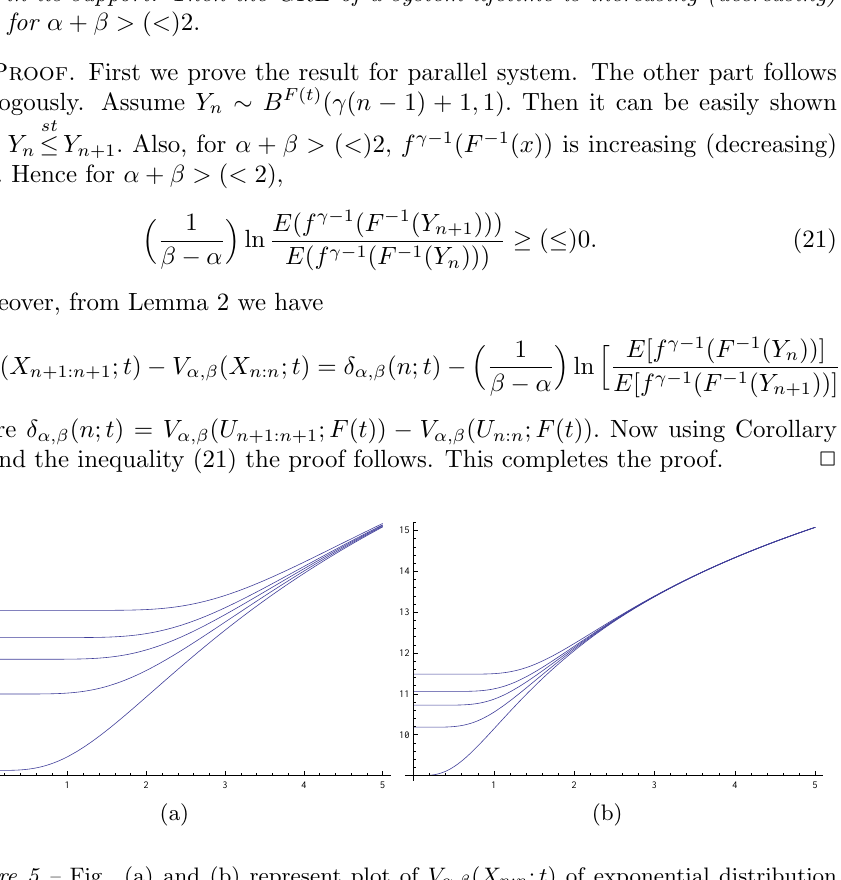
Figure 5 { Fig. (a) and (b) represent plot of V (cid:11);(cid:12) ( X n : n ; t ) of exponential distribution with mean 1 and 0 : 5 ; respectively. Assume (cid:11) = 1 : 2 and (cid:12) = 1 : 5 : Curves corresponds to sample sizes 5 ; 10 ; 15 ; 20 ; 30 are from bottom to